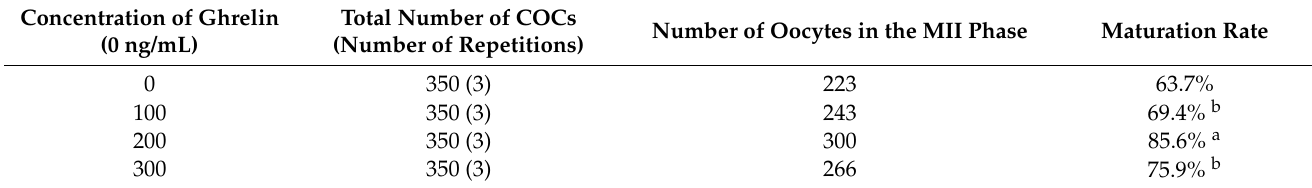
Table 3. Effect of different concentrations of ghrelin on oocyte information